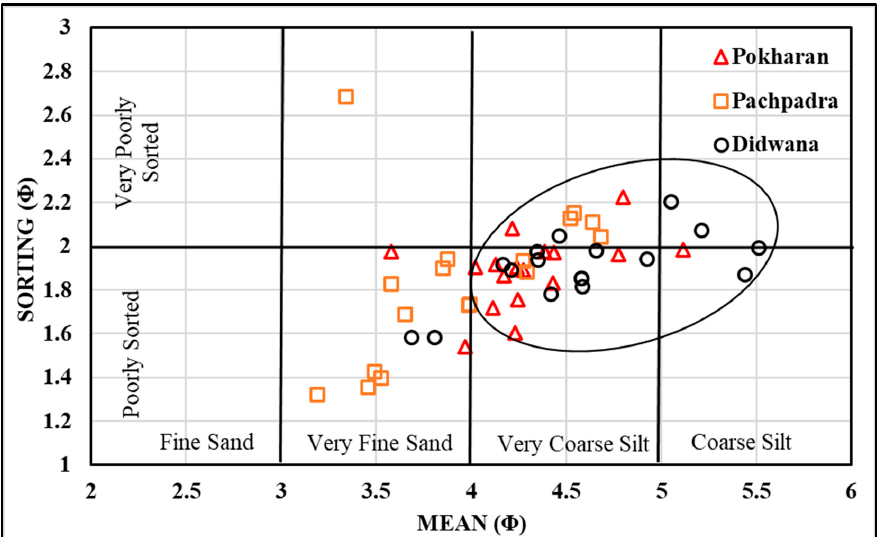
Figure 3. Bivariate plot between mean grain size and sorting.